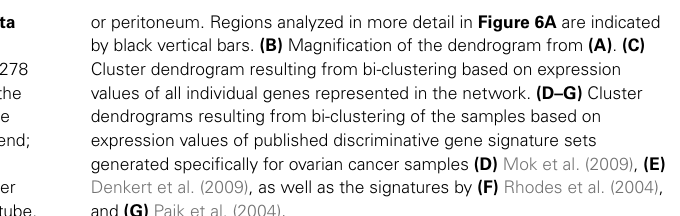
or peritoneum. Regions analyzed in more detail in Figure 6A are indicated by black vertical bars. (B) Magnification of the dendrogram from (A) . (C) Cluster dendrogram resulting from bi-clustering based on expression values of all individual genes represented in the network. (D–G) Cluster dendrograms resulting from bi-clustering of the samples based on expression values of published discriminative gene signature sets generated specifically for ovarian cancer samples (D) Mok et al. (2009), (E) Denkert et al. (2009), as well as the signatures by (F) Rhodes et al. (2004), and (G) Paik et al.